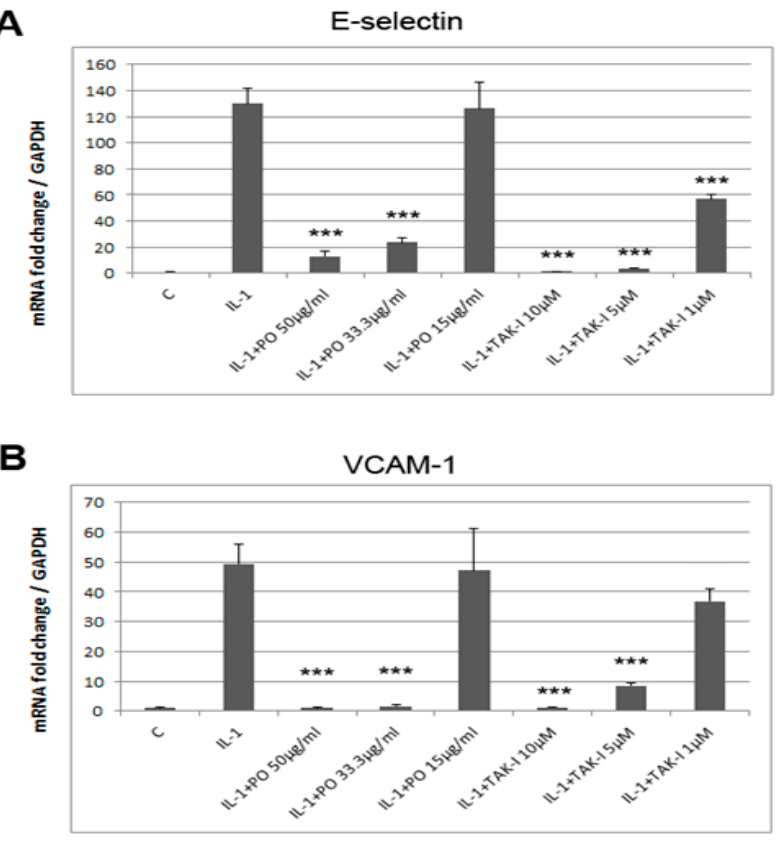
Figure 2. PO inhibits the expression of adhesion molecules in HUVEC. Post-confluent HUVEC were pre-incubated with di ff erent concentrations of PO for 30 min as indicated, then stimulated with IL-1 for 90 min and analyzed by qPCR for mRNA levels of ( A ) E-selectin and ( B ) VCAM-1. Values were normalized to GAPDH and are shown as fold change of IL-1 stimulation vs. unstimulated control. Triplicate samples were analyzed. *** p < 0.001 as compared to IL-1 stimulation. C: unstimulated control; TAK-I: positive control.